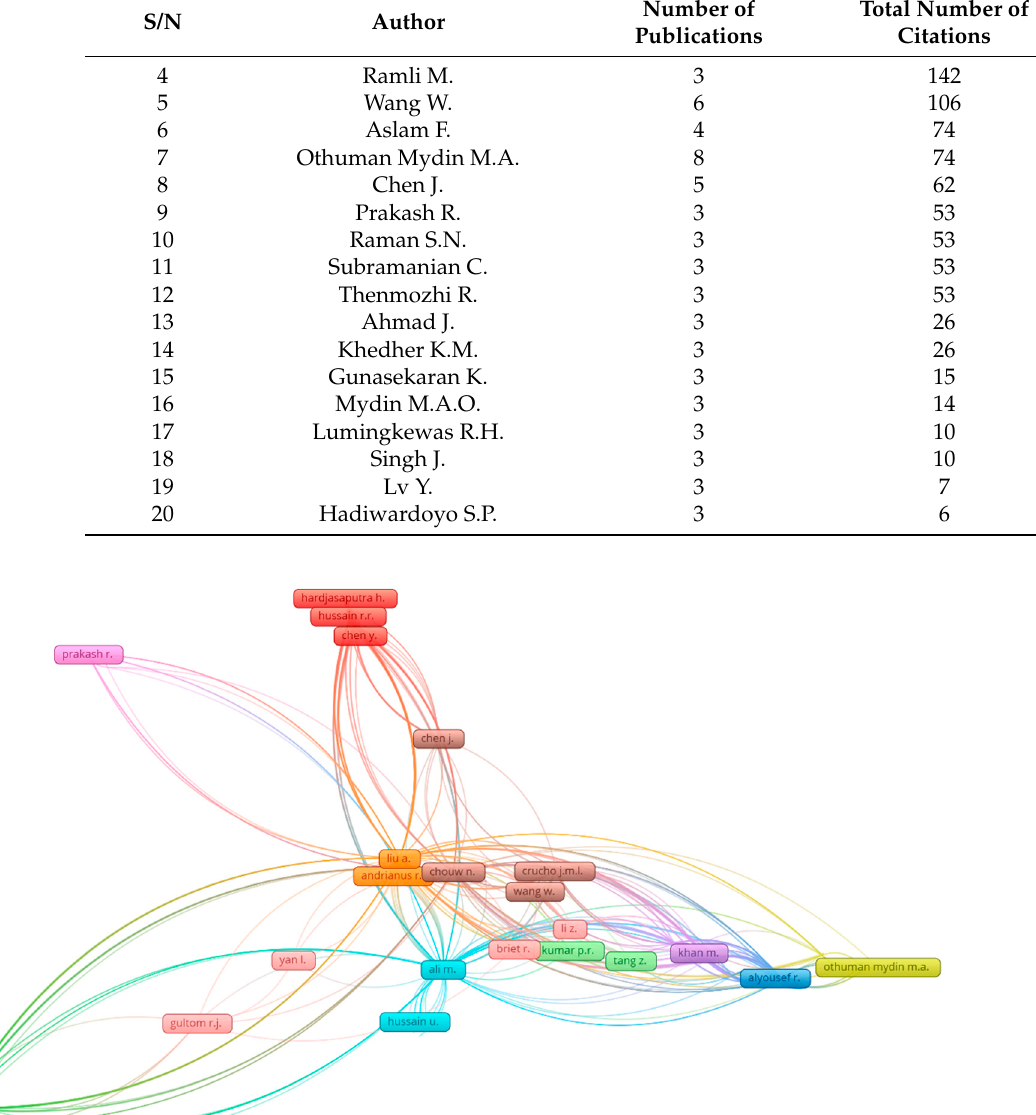
Table 4. Top 10 highly cited published articles up to 2022 in the research of coconut-fiber-reinforced concrete.